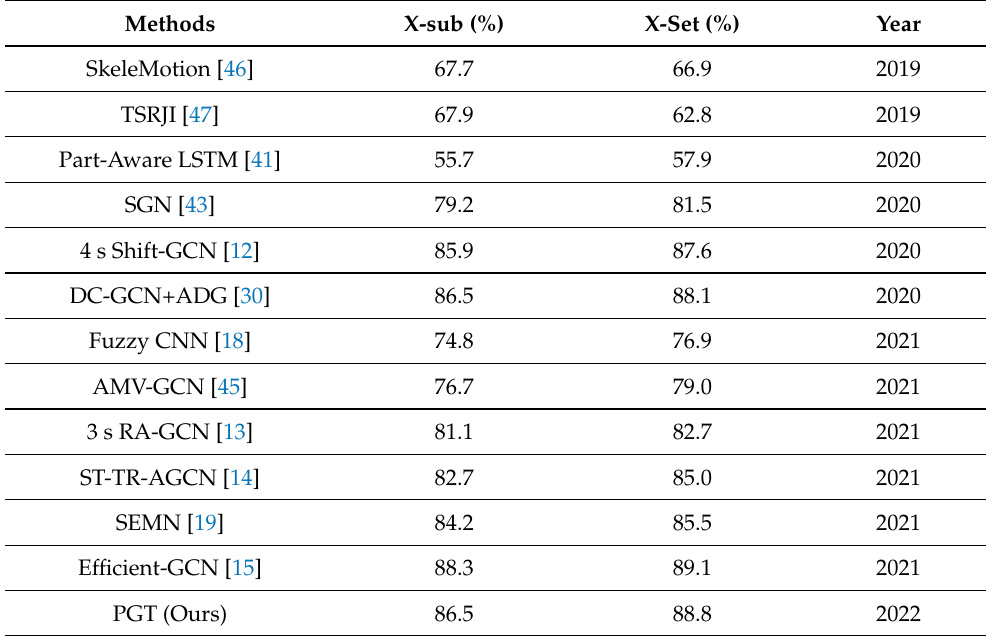
Table 6. Comparisons of the experiment results on the NTU-RGBD 120